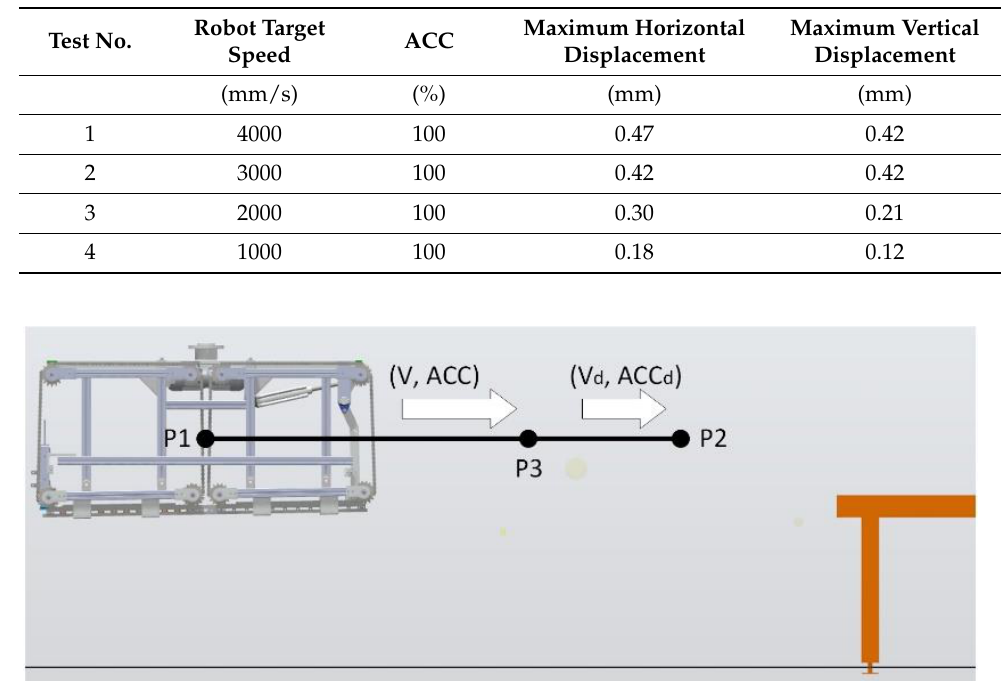
Figure 23. Approach of the robot to the process point. P1 — start point, P2 — process point, P3 — intermediate point, V — linear speed of the robot, ACC — acceleration coefficient, Vd — approach linear speed of the robot to the process point, ACCd — acceleration coefficient to the process point.